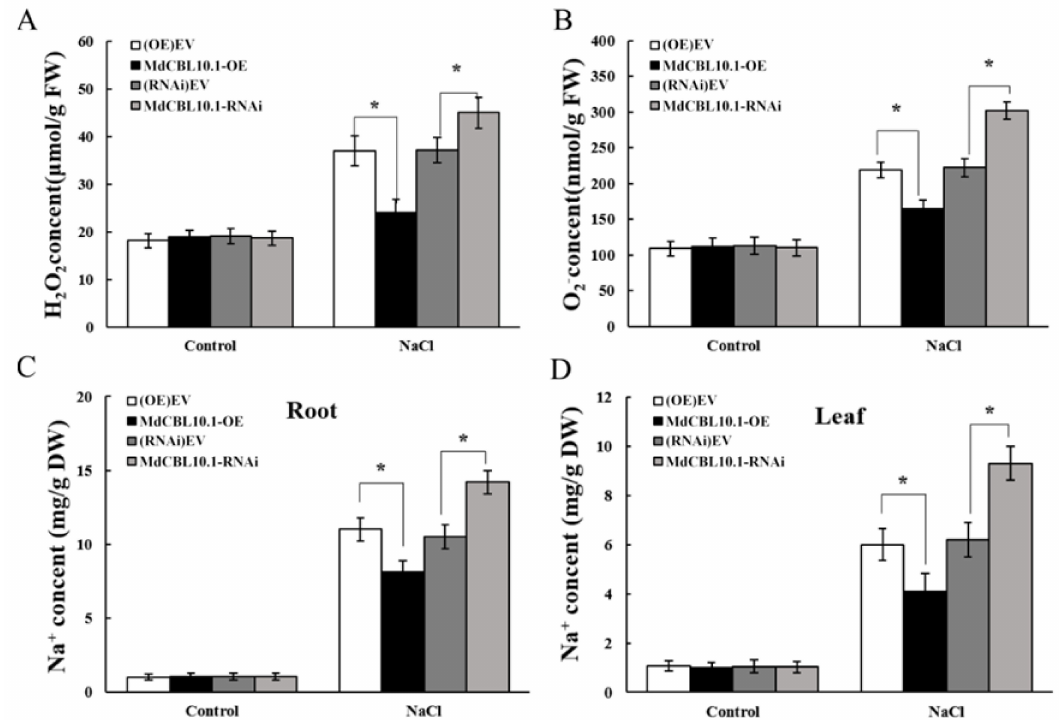
Figure 7. Overexpression of MdCBL10.1 in apple roots inhibited the ROS and Na + accumulation in cisgenic apple plants. ( A ) Hydrogen peroxide (H 2 O 2 ) content in roots. ( B ) Superoxide anion (O 2 − ) content in roots. ( C ) Na + content in roots. ( D ) Na + content in leaves. The values of each index are the average values of all lines in cisgenic plants of the same type. Values are means of 20 replicates ± SD. * in each panel denotes values significantly different from the corresponding control lines ( p < 0.05, Student t